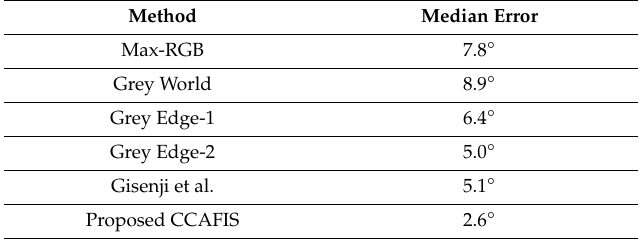
Table 6. Median recovery angular errors for 9 outdoor images of the multiple light source